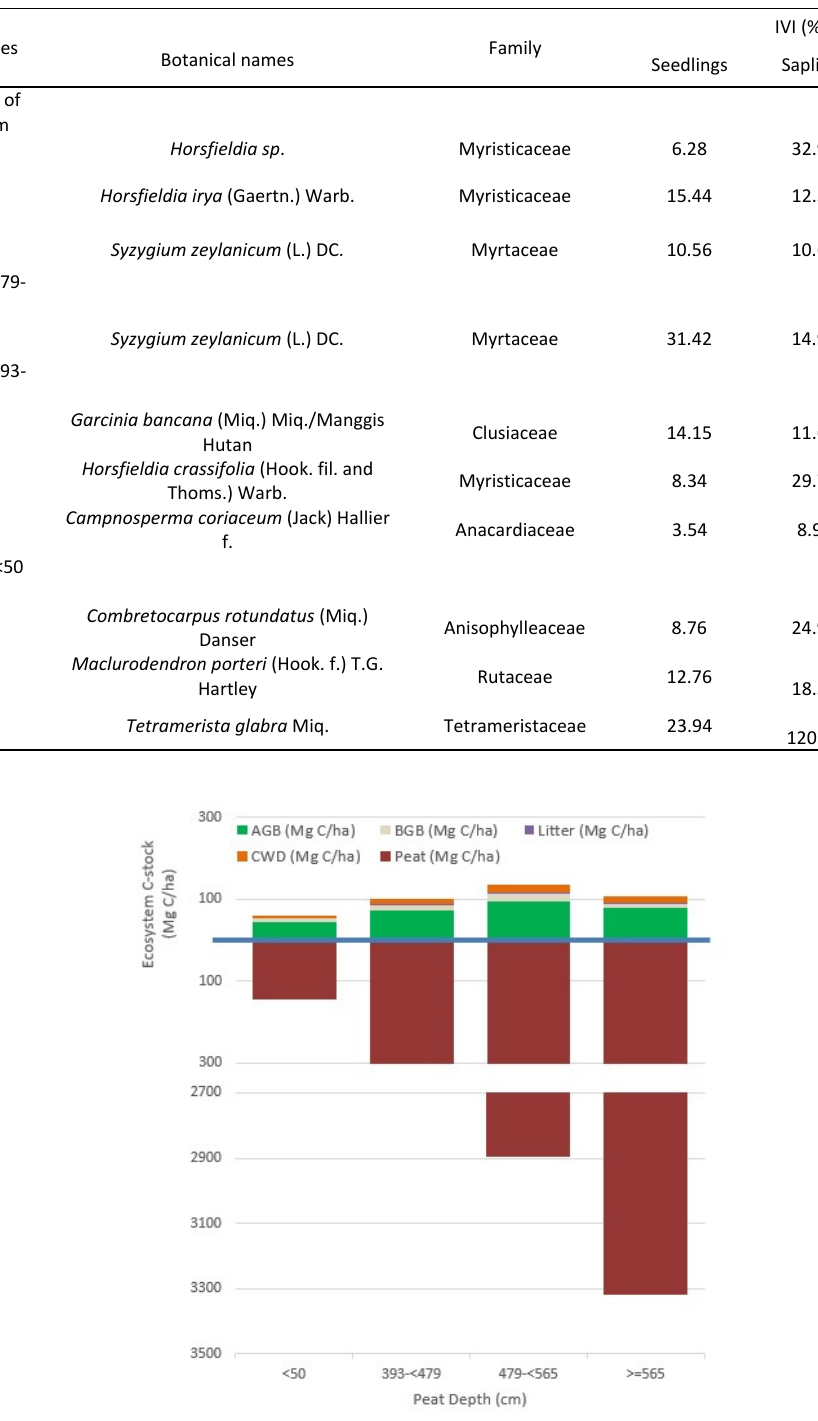
Fig. 9: Profiles of ecosystems of carbon stock at different peat depths.